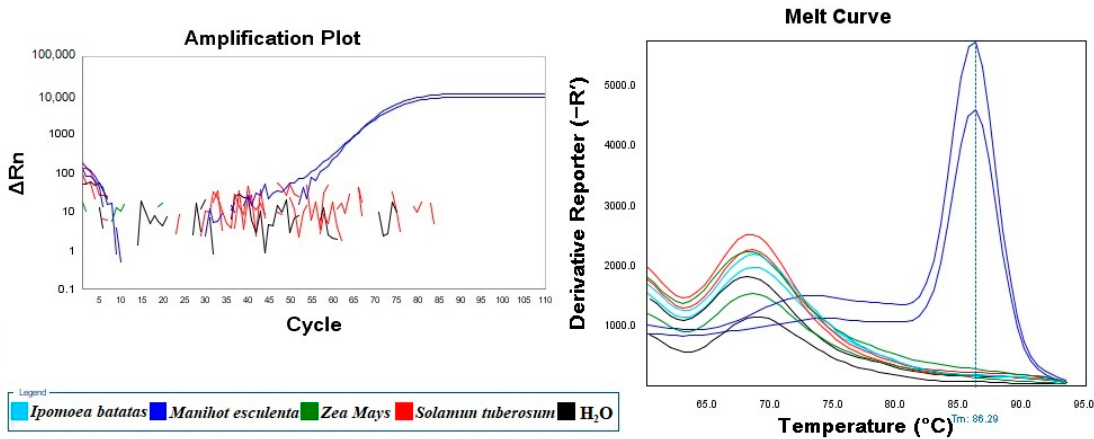
Figure 3. Specificity of the Real-time LAMP Assay.